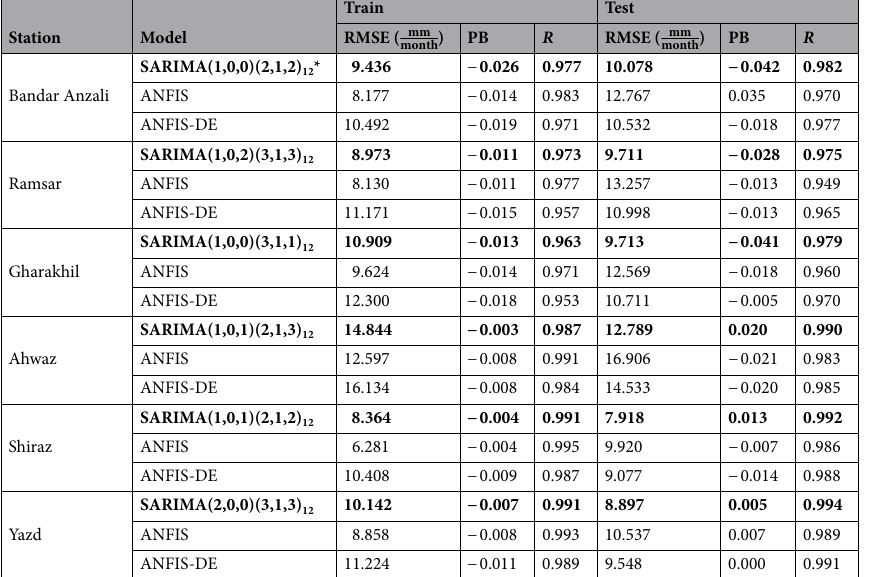
performance of the models in predicting monthly ET0 (the minimum value of R is equal to 0.949, which belongs to the simple ANFIS model in Ramsar station). Additionally, the amount of PB in all cases is very small (close to zero), which confirms the lack of significant under/overestimation and, consequently, the excellent performance of the models. According to Table 4, the SARIMA linear model has superior performance in all stations than the other two models, and the weakest performance among the models belongs to the simple ANFIS model. In combination with the ANFIS model (ANFIS-DE), the DE algorithm was able to increase the prediction accuracy for ANFIS by an average of 15.8%. The lowest prediction error belongs to the SARIMA model at Shiraz station with RMSE = 7.918 mm month . The highest prediction error is reported in Ahwaz station with RMSE = 16.906 mm month , which belongs to the simple ANFIS model. Comparing the models. Scatter plots are used for graphical illustration of the correlation between the predicted and actual values of monthly ET0 (Fig. 6). In Fig. 6, the horizontal axis of the graphs represents the observed ET0 data, and the vertical axis represents the predictions presented by the models. This figure shows that, at all stations, the slope of the fitted regression line between the observed-predicted data samples is very small, associated with the X = Y line. The points are well concentrated around their regression line, and this concentration is more on the diagrams related to the SARIMA model than the other two models. On the other hand, the R 2 coefficient shows that the SARIMA linear model offers a better prediction than the other two nonlinear and complex models, i.e., ANFIS and ANFIS-DE. Also, ANFIS-DE predictions show better correlations compared to simple ANFIS. The diagrams in Fig. 6 show that the weakest performance belongs to the predictions of ANFIS in Ramsar ( R 2 = 0.901), and the best performance belongs to the predictions of SARIMA at Yazd station ( R 2 = 0.984). The Taylor diagram is also represented for each station to compare the models (Fig. 7). This diagram (Fig. 7) can simultaneously check the correlation and the error and also compare the standard deviations of the outputs of several models and their observed values. In these diagrams, point O is an indicator of observed data, and points A, B, and C are the indicators of the SARIMA, ANFIS, and ANFIS-DE models, respectively. At all stations, point A is located closest to point O, confirming the superiority of the SARIMA model. After that, ANFIS-DE (point C) and ANFIS (point B) models are located in the second and third places, respectively. The best position of points A, B, and C belongs to Shiraz station, where these points are placed between two circles RMSE = 5 mm month and RMSE = 10 mm month , and around the radius R = 0.99. At Yazd station, a situation similar to Shiraz station is observed. The weakest points’ position can belong to Bandar Anzali station, where points A, B, and C are farthest from point O, between circles of RMSE = 10 mm month and RMSE = 15 mm month , and between two radii of R = 0.99 and R = 0.95. Furthermore, a comparison of the standard deviations between outputs and the observations reveals that the points of the models, especially point A, are in a favorable position relative to the quadrant close to point O. This shows that the models, especially SARIMA, can favorably estimate the standard deviation of actual ET0 values. Comparing ET0 prediction accuracy in different climates. In general, the comparison between the stations in Fig. 7 indicates that the humid stations are in weaker ranges of error and correlation than the arid